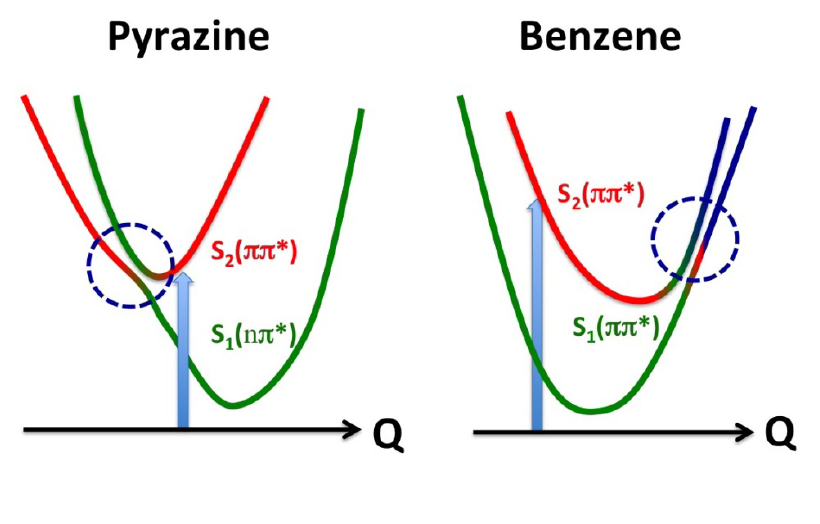
Figure 16. Comparison of conical intersections in pyrazine and benzene. The vertical arrows indicate photoexcitation, and the horizontal axes are the reaction coordinates. The red and green correspond respectively to the diabatic S contribution of other zero-order electronic